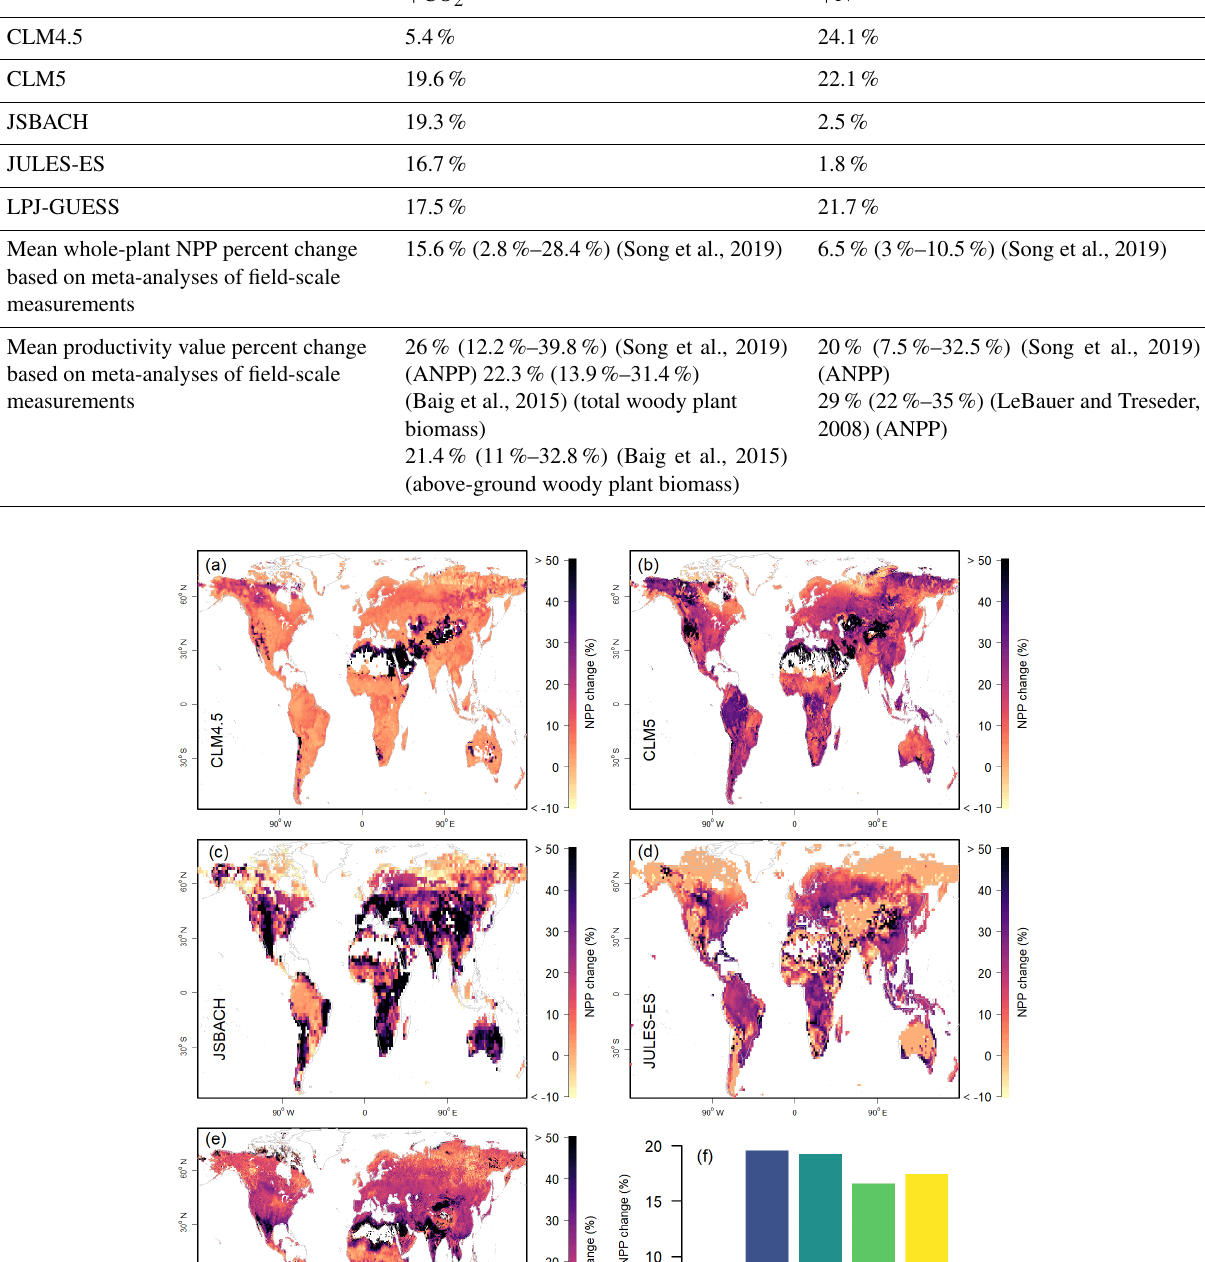
Table 2. Percent change in mean global NPP from perturbations. The observations come from meta-analyses which may not be directly comparable but which provide a useful context. ANPP represents above-ground NPP.